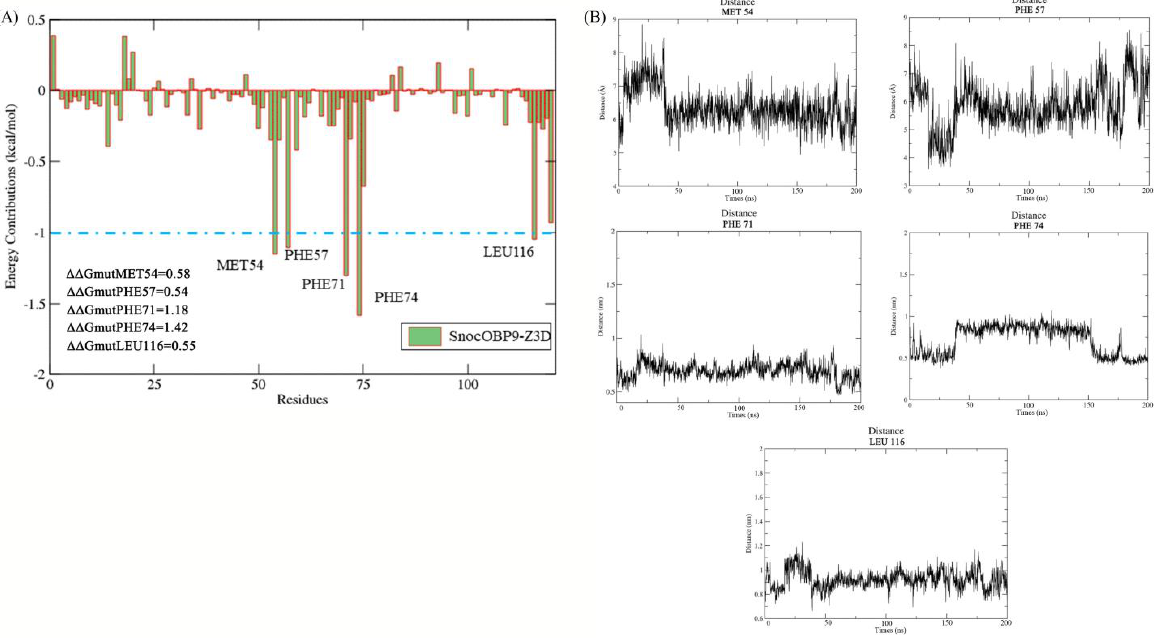
Figure 10. ( A ) Each residue for the SnocOBP9-Z3D complex calculated from the equilibrated conformations with 100–200 ns MD. Residues contributing more than − 1.00 kcal/mol to the binding free energy are marked by the blue line. ( B ) Centroid distance between the five key amino acids and Z3D. Table 6. The decomposition for the important residues contributing to the binding free energy and the average centroid distance between the five key amino acids to Z3D.